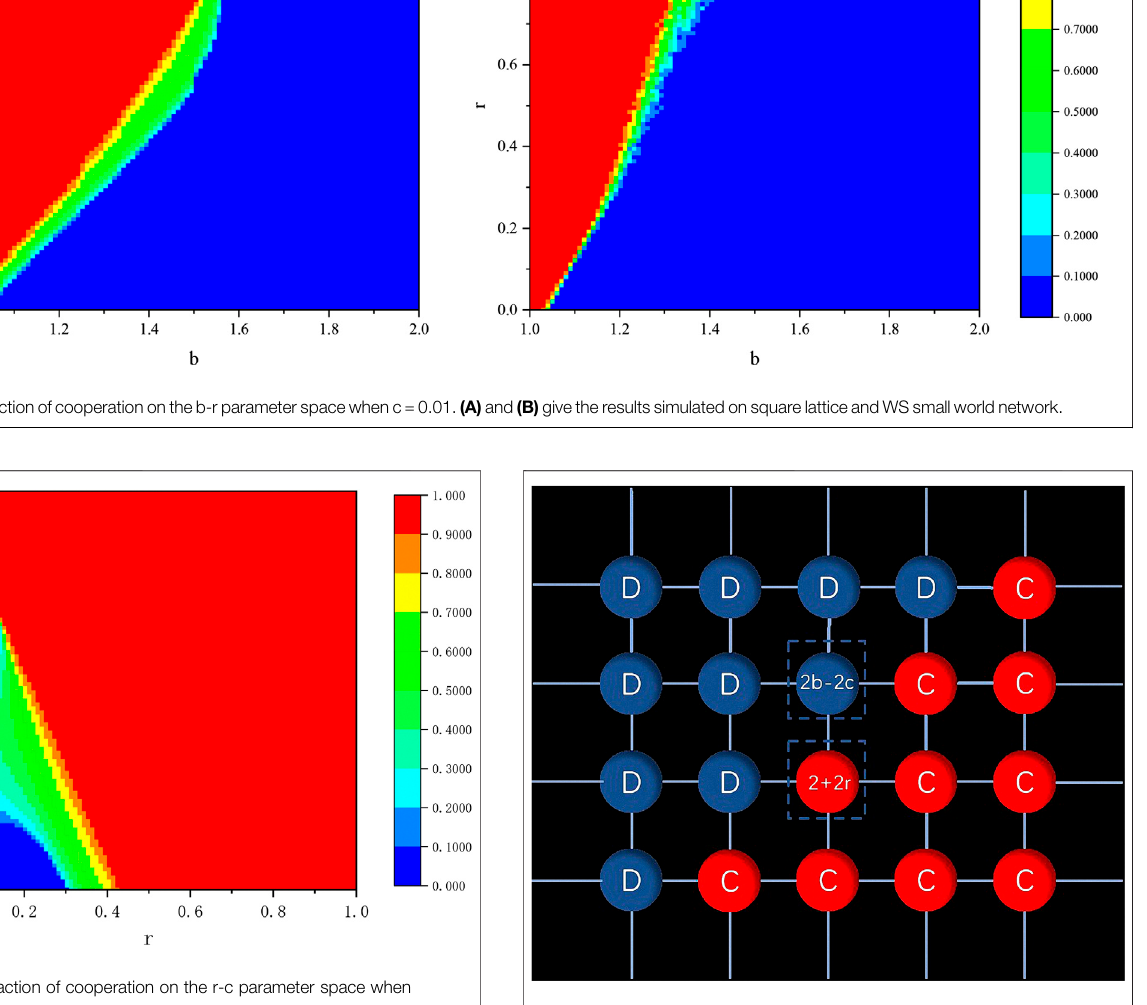
FIGURE 3 | Schematic of the boundary structure. Cooperator (defectors)arepresentedinred(blue).Weshowthepayoffsofthenodesinthe dotted